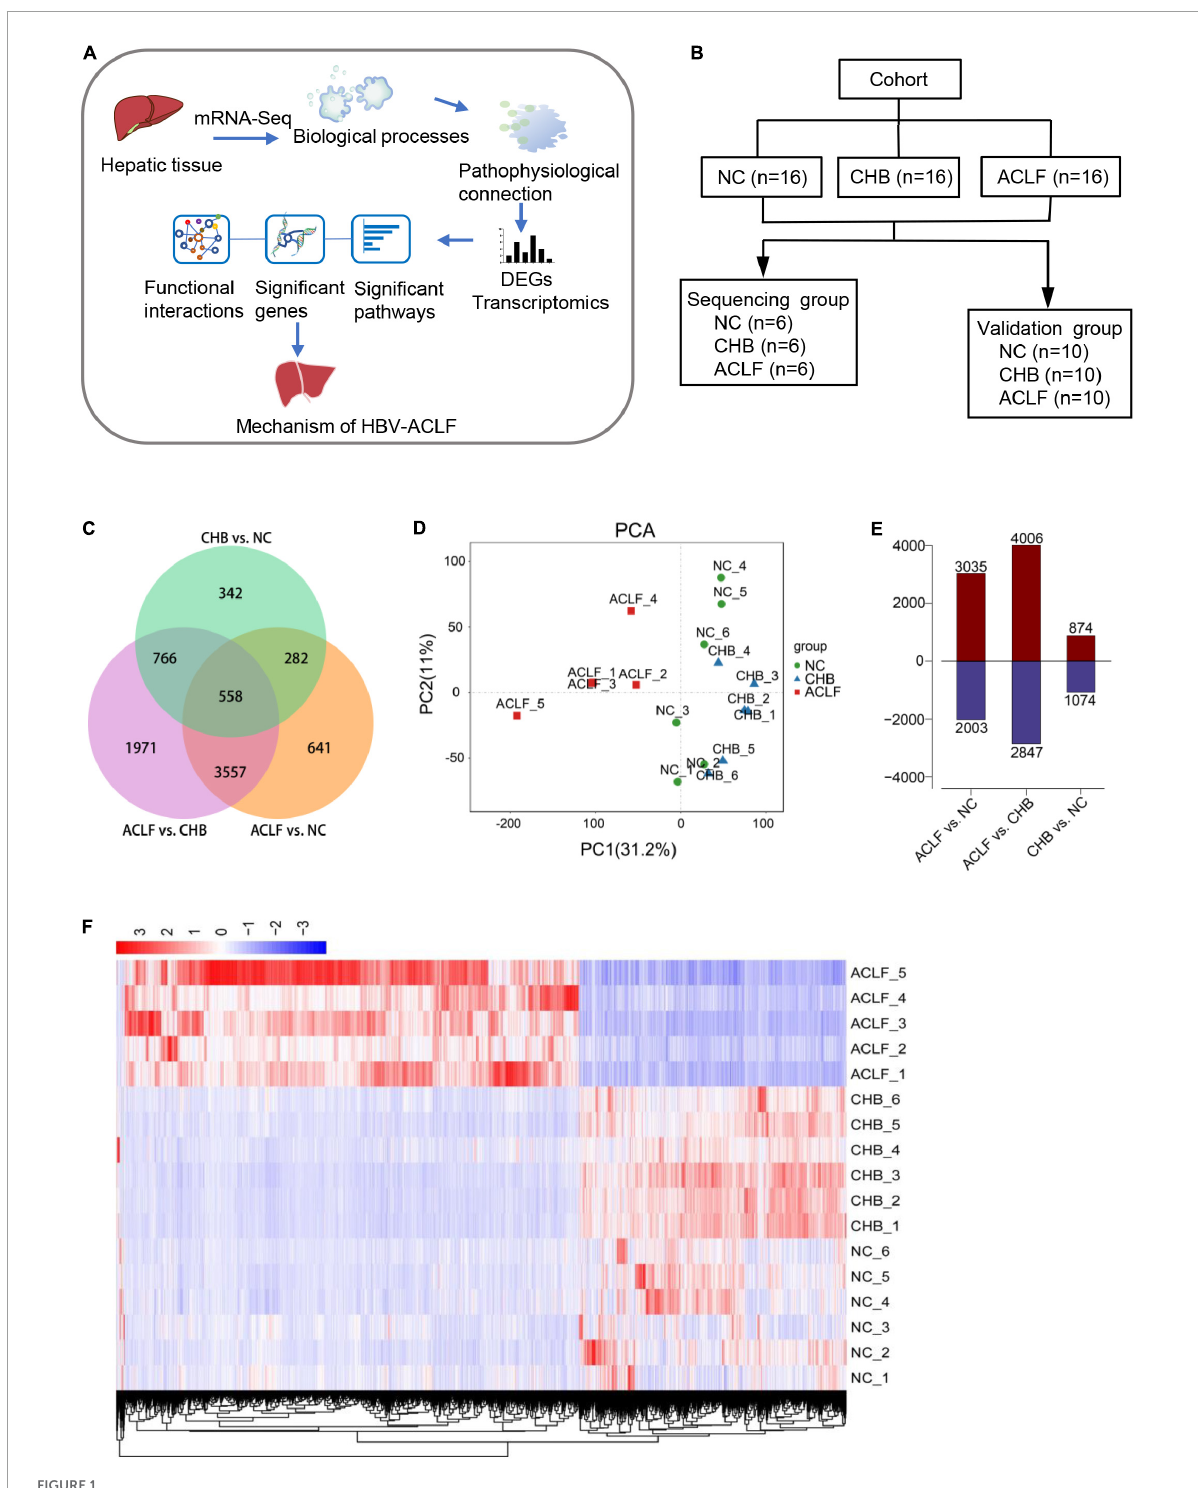
FIGURE1 Transcriptomic features in patients with HBV-ACLF. (A) Flow diagram of the strategy used for analysis of functional synergy. (B) Study design and patient group allocation. (C) Venn diagram of the DEGs analyzed in pairwise comparisons among subjects in the acute-on-chronic liver failure (ACLF), chronic hepatitis B (CHB) and normal control (NC) groups. Numbers of mRNA sequences ( n = 5/6/6, ACLF/CHB/NC groups). (D) PCA of subjects in the ACLF, CHB, and NC groups. (E) Numbers of significant DEGs in the pairwise comparisons. (F) Distribution of the 4115 DEGs in HBV-ACLF, CHB and NC subjects. HBV-ACLF, HBV-related acute-on-chronic liver failure; CHB, chronic hepatitis B; NC, normal control; DEGs, differentially expressed